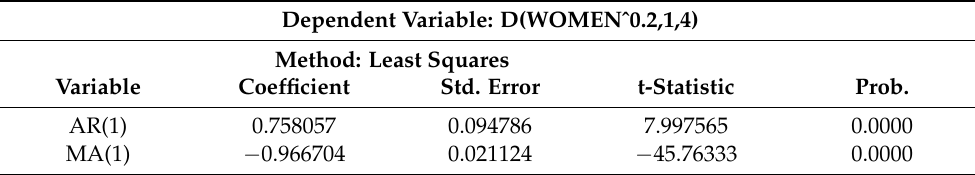
Table 7. Estimation of the demand for gastronomic tourism in Andalusia. Dependent Variable: D(WOMENˆ0.2,1,4) Method: Least Squares Variable Coefficient Std. Error t-Statistic Prob. AR(1) 0.758057 0.094786